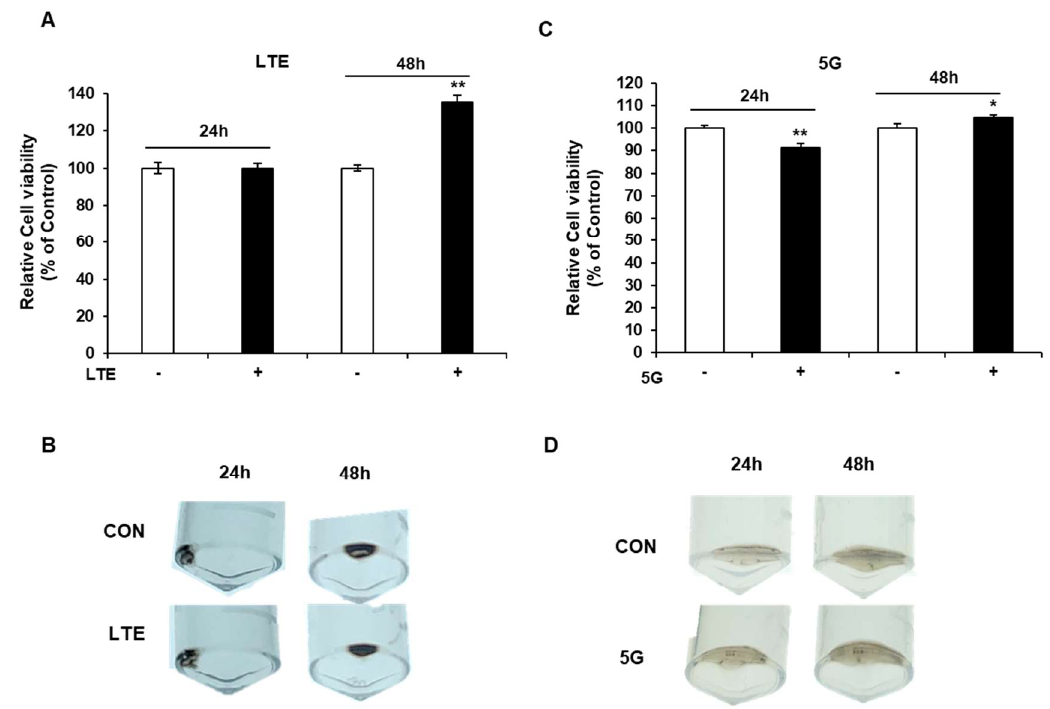
Figure 1. Effects of long-term evolution (LTE) and 5G on cell viability and melanin synthesis. The murine melanoma cell line, B16F10, or human melanoma cell line, MNT-1, were exposed to either LTE (1.762 GHz) or 5G (28 GHz) for 4 h per day for 2 days. ( A , B ) Cell viability was determined by 4-[3-(indophenyl)-2-(4-nitrophenyl)-2H-5-tetrazolio]-1,3-benzene disulfonate (WST-1) assay or 3-(4,5-dimethylthiazol-2-yl)-2,5- diphenyltetrazolium bromide (MTT) assay. ( C , D ) Macroscopic view of MNT-1 cell pellets observed after 4 h exposure of LTE or 5G. Data are presented with the mean ± SE (N = 3~5). * p < 0.05, ** p <